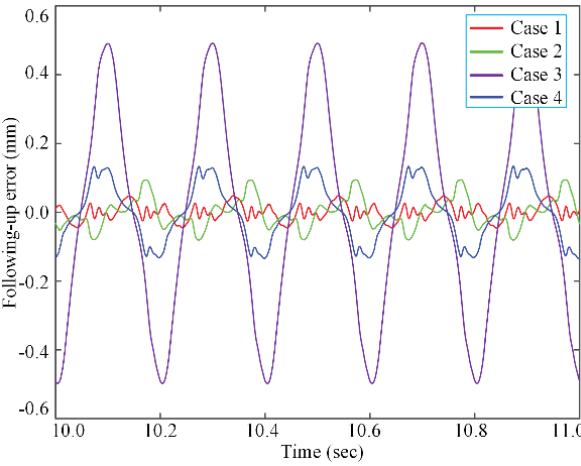
Figure 12. Following ‐ up errors within 1.0s.